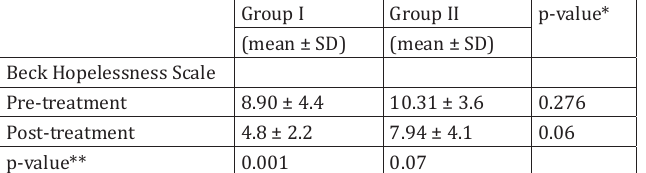
Intra- and intergroup comparisons of Beck Hopelessness Scale